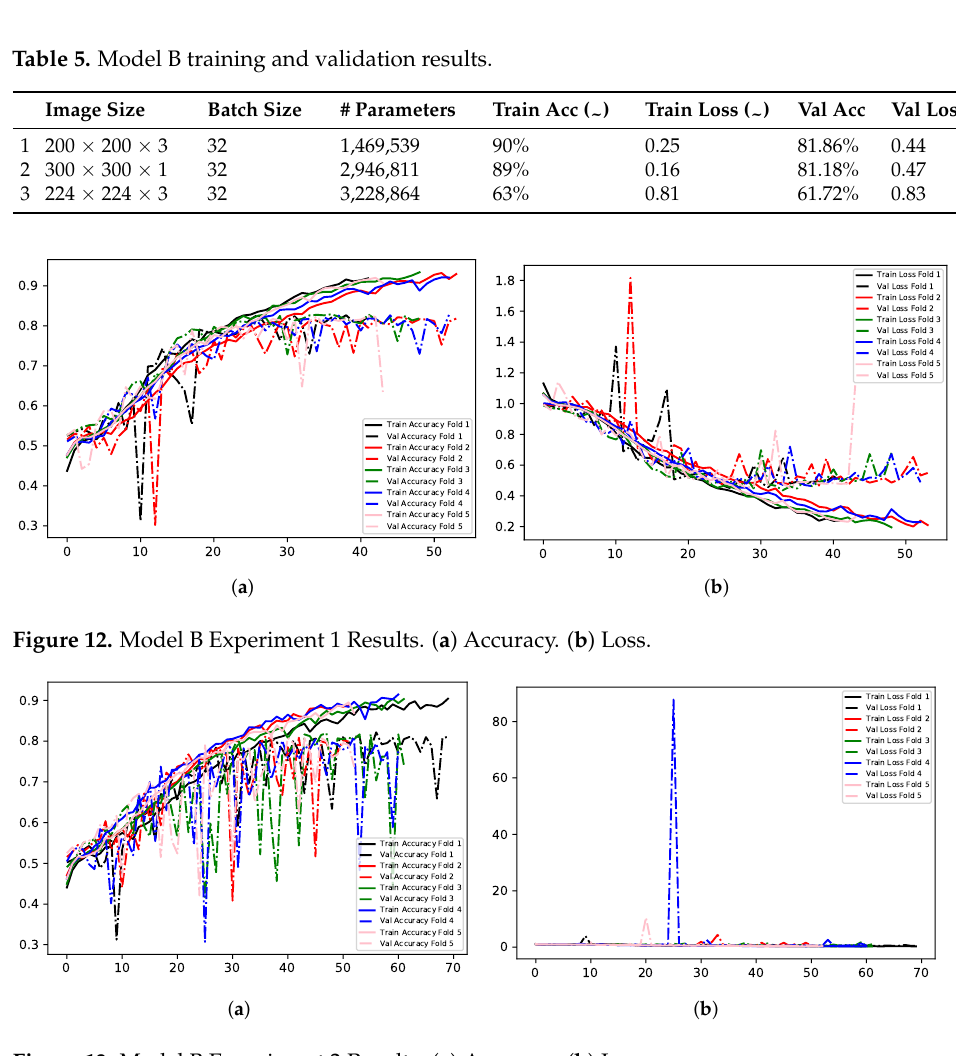
Figure 13. Model B Experiment 2 Results. ( a ) Accuracy. ( b ) Loss.